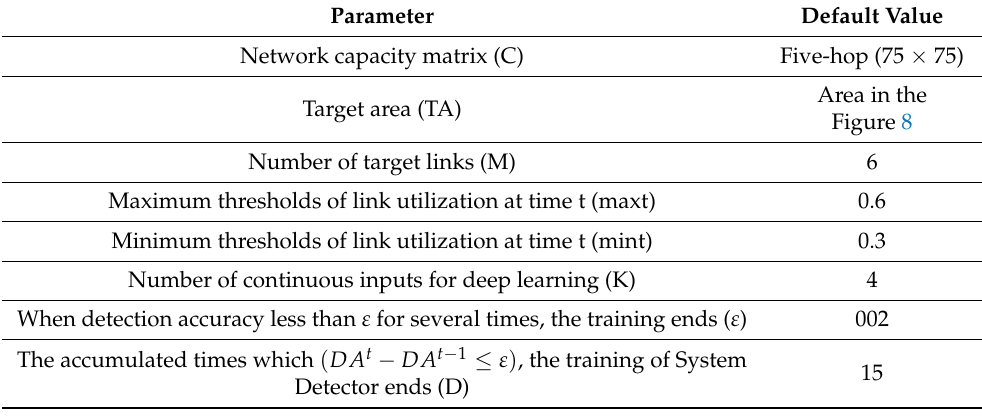
Table 5. SCL parameter setting.